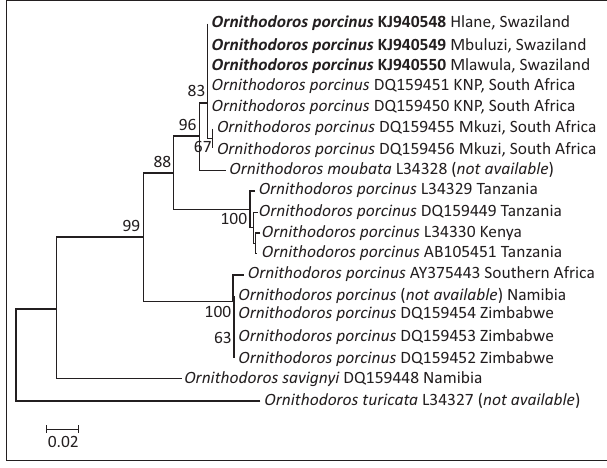
FIGURE 2: Neighbour joining tree depicting 16S rRNA gene relationships of Ornithodoros ticks sampled from three Swaziland wildlife